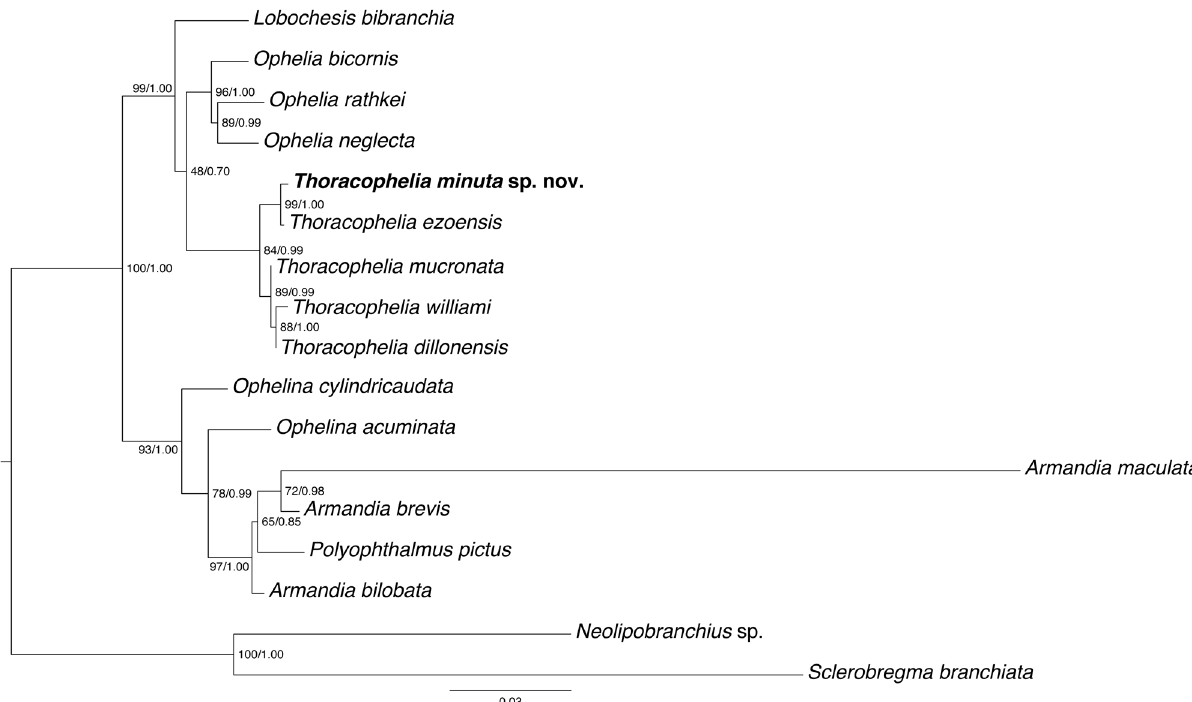
Figure 3. Maximum-likelihood (ML) phylogenetic tree of Opheliidae based on 18S and 28S sequences. Neolipobranchius sp. and Sclerobregma branchiata were used as ‘outgroups’ for the rest of the opheliids. Nodal support values (bootstrap support [BS] value) higher than 50% are indicated on each branch. The figure was created with Adobe Illustrator v